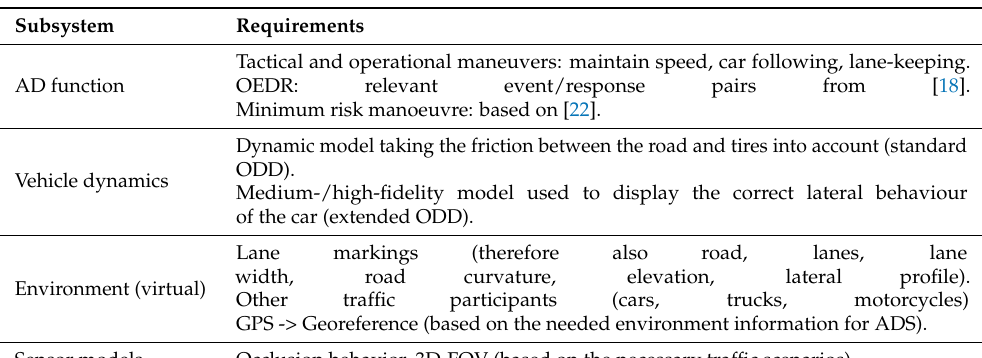
Table 4. Requirements for the different subsystems of the virtual validation framework for the ALKS with a standard and extended ODD.